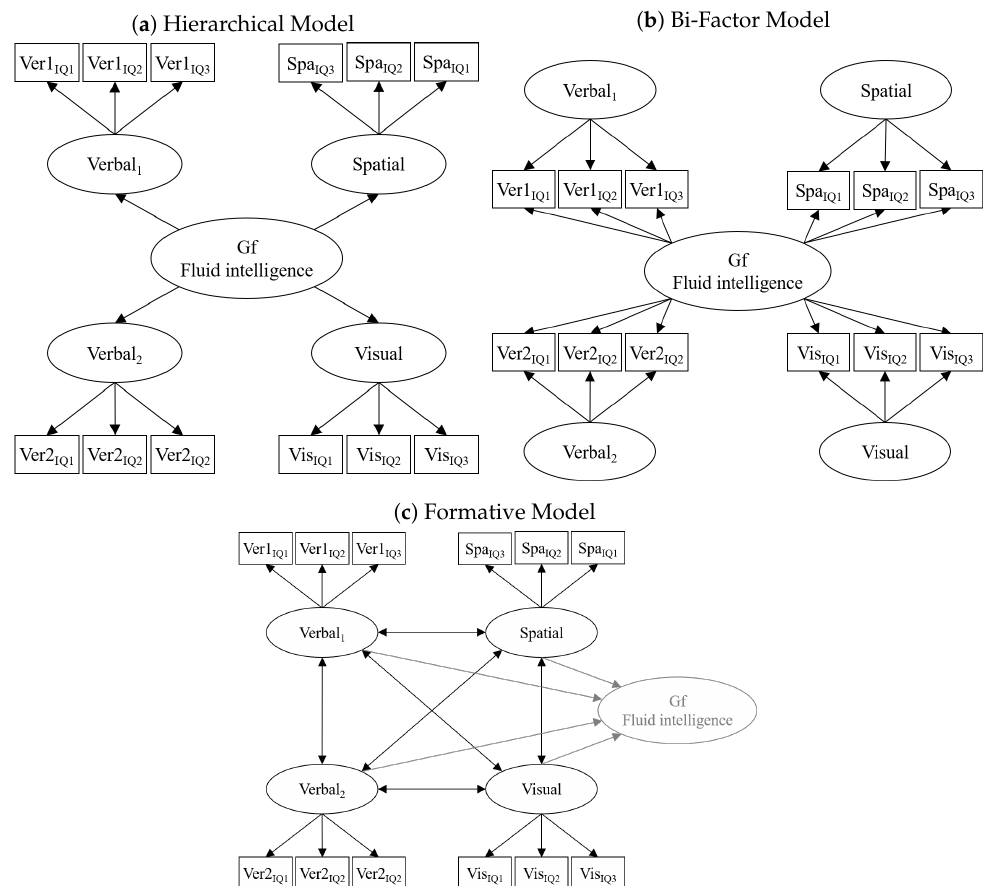
Figure 2. Simplified path diagrams of Gf models either assuming a reflective higher-order factor of Gf ( a , b ) or a formative factor Gf arising from correlated indicators ( c ). The two models at the top are alternative implementations of a reflective measurement model. Specifically, the hierarchical factor model assumes different levels of generality, whereas the bi-factor model reflects the breadth of a Gf factor. From a statistical perspective, these two models are highly similar, and the hierarchical model can be described as a special case of the bi-factor model (Gignac 2016). The bottom model assumes that factors capturing individual differences in Gf measures are correlated with each other, but, instead of a higher-order factor determining these correlations, a Gf factor emerges from these correlations. However, this emerging factor cannot be modeled in this specification because it is not identified. Error variances and residual variances of endogenous latent variables were omitted for illustration